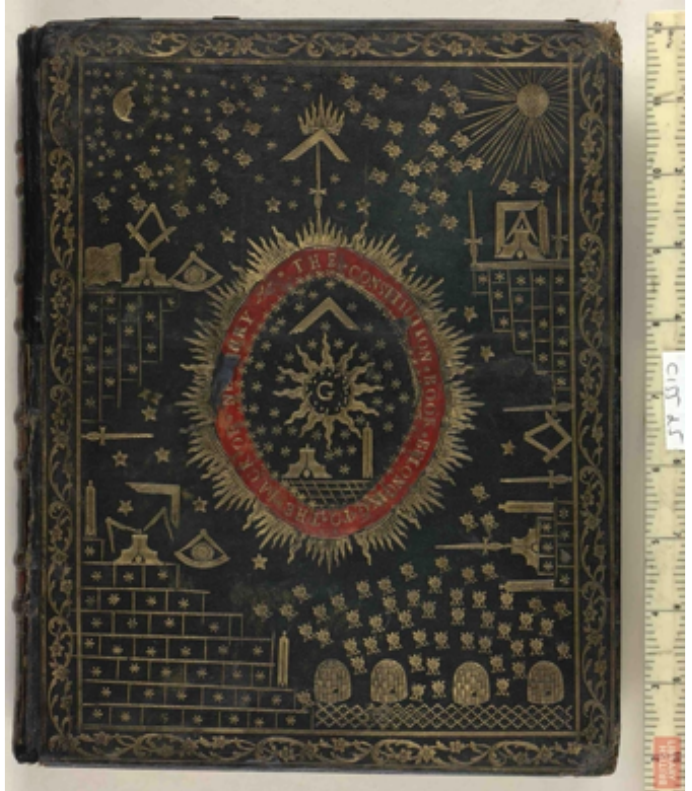
Fig. 26. The Constitutions of the ... Masons, 1767. BL,